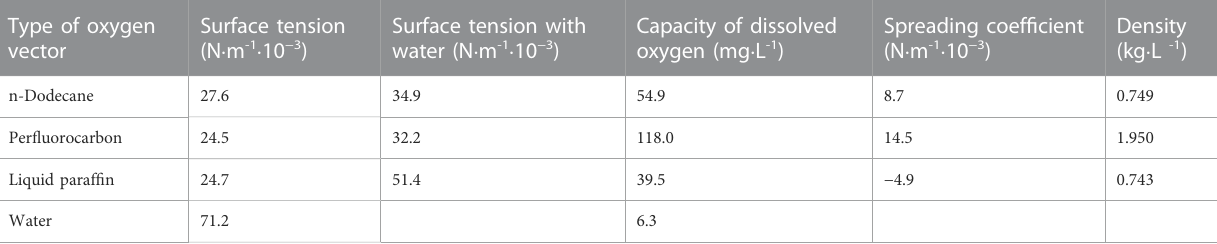
TABLE 1 Properties of oxygen vectors. Type of oxygen